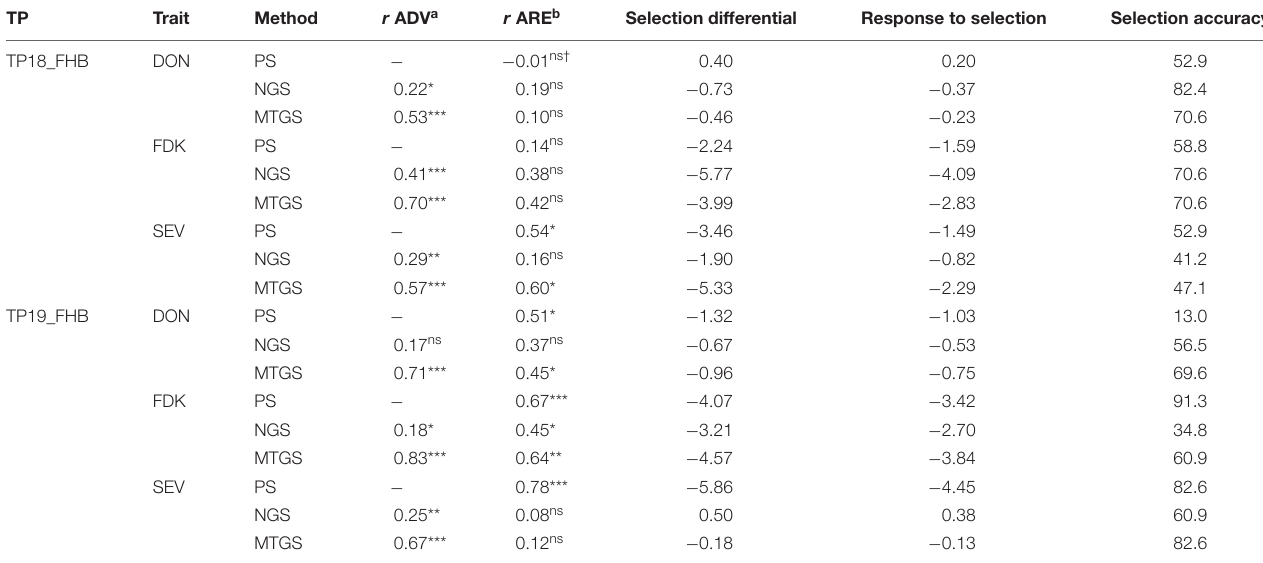
TABLE 3 | Comparison of three selection methods, phenotypic selection based on three FHB resistance traits using two training populations (TP), deoxynivalenol (DON) concentration, Fusarium damaged kernels (FDK), and severity (SEV) from the advanced trials (ADV), naïve genomic selection (NGS), and multi-trait genomic selection (MTGS), based on correlations between genome estimated breeding values and the adjusted means from following generations, response to selection, and selection accuracy of genotypes in the final generation. TP Trait Method r ADV a r ARE b Selection differential Response to selection Selection